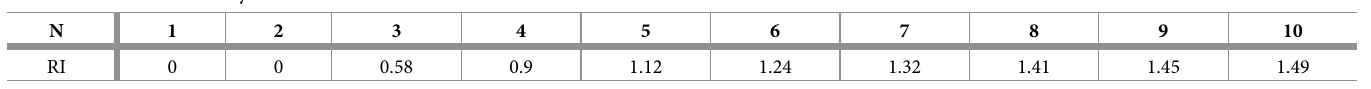
Where CI indicates the Consistency Index, the ( λ ) equals the main number of Eigen and Max n , the number of criteria in the matrix, 7 in this case. To check whether the resulting value of CI is adequate for the problem, the Consistency Ratio (CR) was established by [34]. The matrix is considered consistent if the resulting value is less than 10% [35]. The value of RI can be observed through a table with fixed values used as reference and cal- culated in the laboratory, and are presented in Table 1. Then: the CR is determined by the ratio between the value of the consistency index and Random Index (RI) CI < 0 : 1 � 10 ð 2 Þ CR ¼ RI